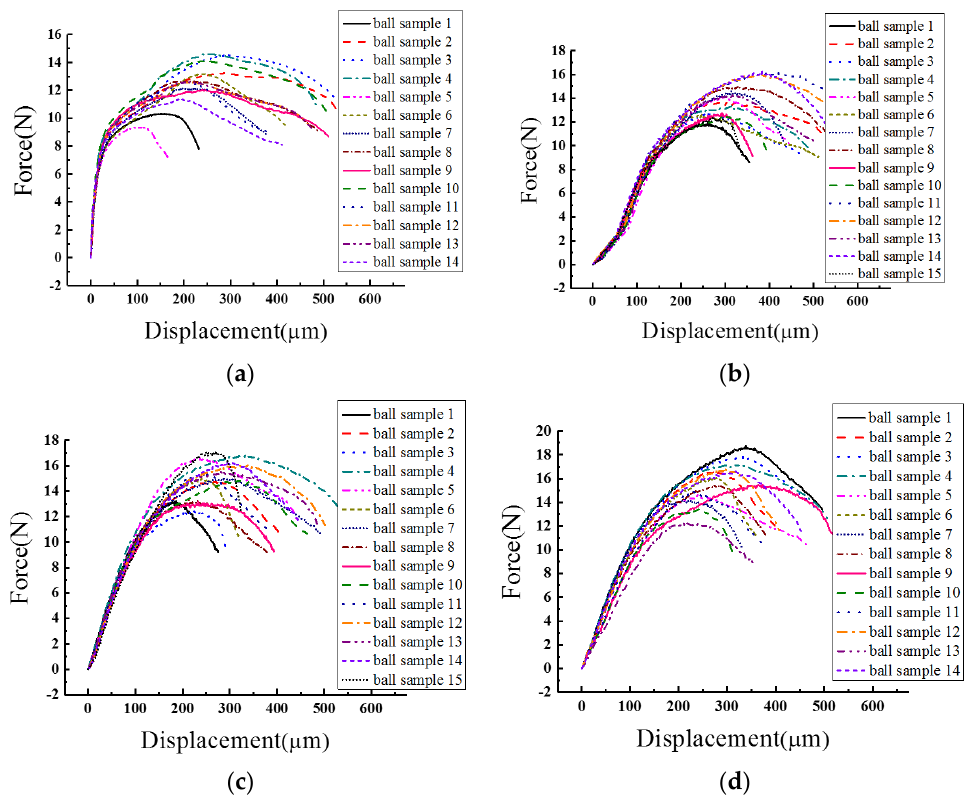
Figure 3. Force − displacement result curves at four representative shearing speeds: ( a ) 20 μ m/s; ( b ) 80 μ m/s; ( c ) 150 μ m/s; and ( d ) 200 μ m/s.